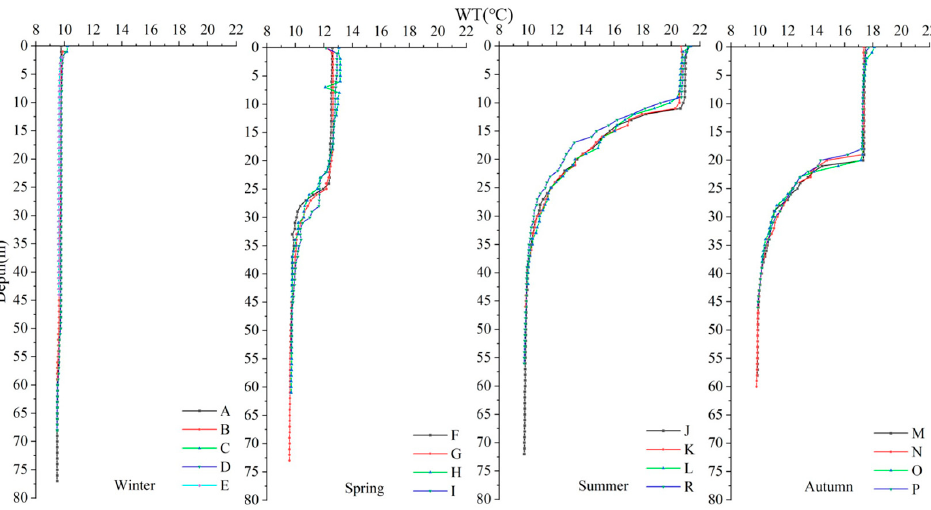
Figure 2. Seasonal variations of vertical water temperature (WT) section in Lake Lugu.